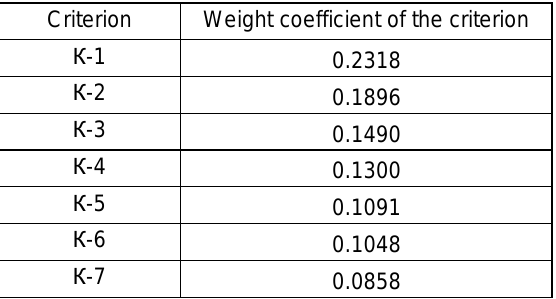
339 Table 1 – Values of the weight coefficients of the criteria